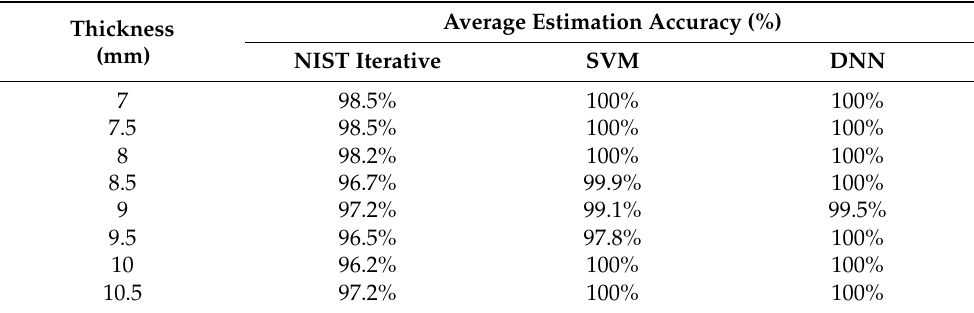
Table 3. Thickness estimation accuracy among the NIST iterative method, the SVM model, and the DNN model. Average Estimation Accuracy (%) Thickness (mm) NIST